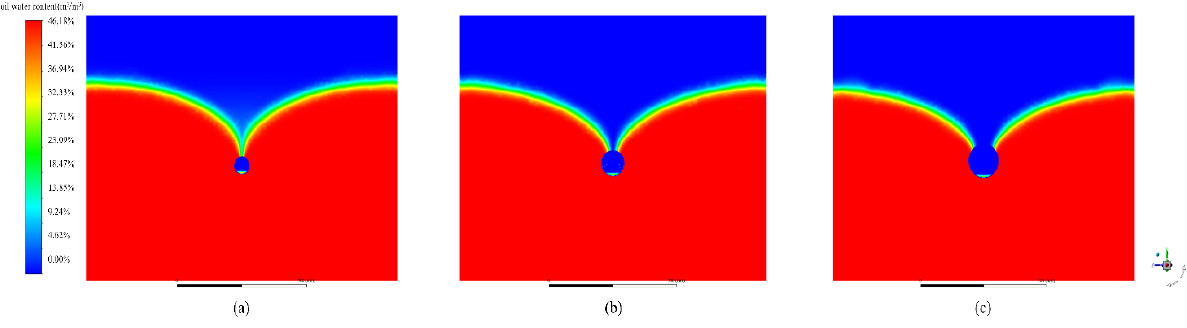
Figure 10. Soil water content of the pipe outside diameter (mm) = ( a ) 60 mm, ( b ) 90 mm and ( c ) 120 mm.